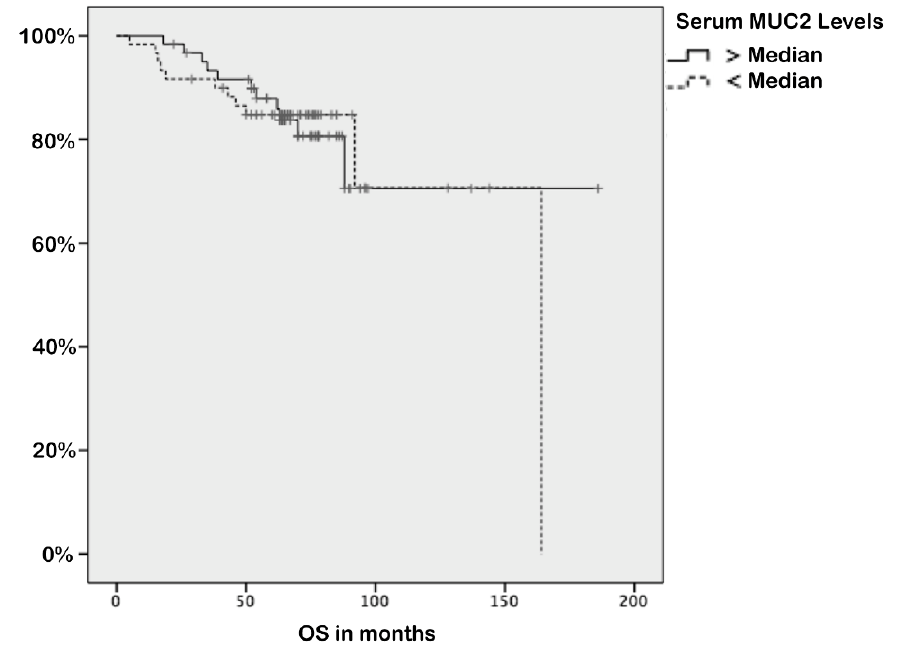
Figure 3. Kaplan–Meier survival curves in breast cancer patients according to serum MUC 2 levels ( p = 0.65). OS: overall survival.